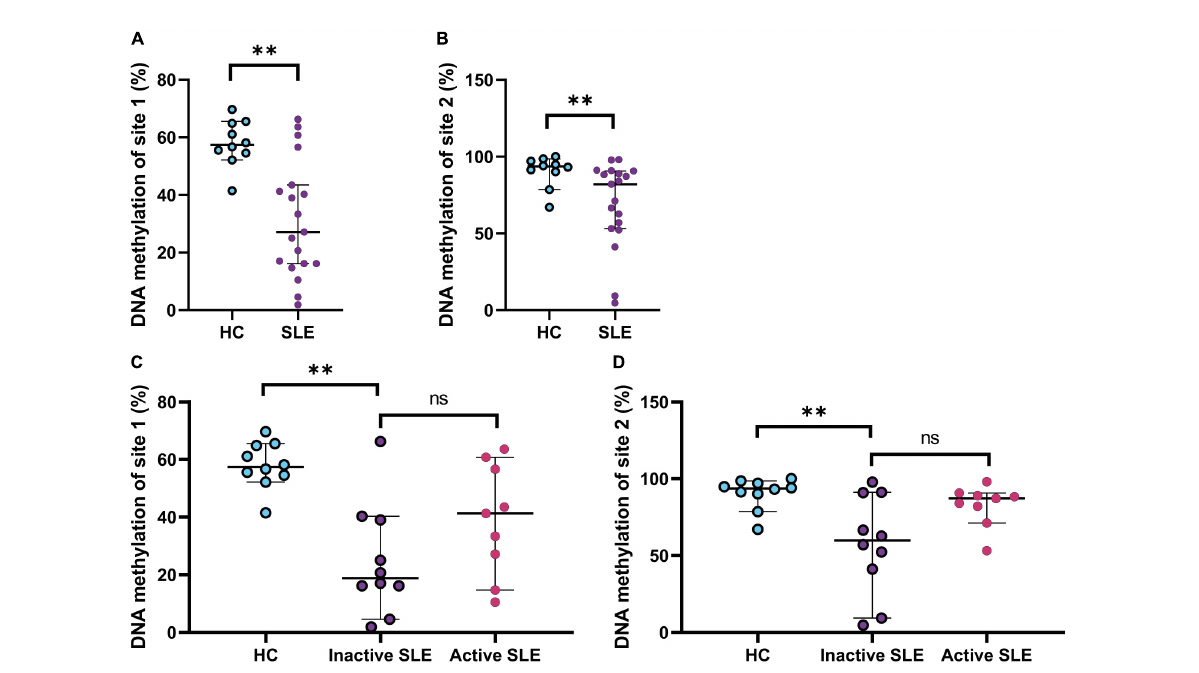
FIGURE4 DNA methylation status of IFI44L gene on rNAV B cells. (A) Percentage of DNA methylation of site 1 on the promoter of the gene IFI44L in HC and SLE patients. Mann–Whitney T -test was used to analyze and median and 95% CI are depicted in the figures. (B) Percentage of DNA methylation of site 2 on the promoter of the gene IFI44L in HC and SLE patients. Mann–Whitney T -test was used to analyze and median and 95% CI are depicted in the figures. (C) Percentage of DNA methylation of site 1 on the promoter of the gene IFI44L on HC, inactive and active SLE patients. Kruskal Wallis with multiple comparisons used to analyze and median and 95% CI are depicted in the figures. (D) Percentage of DNA methylation of site 2 on the promoter of the gene IFI44L on HC, inactive and active SLE patients. Kruskal Wallis with multiple comparisons used to analyze and median and 95% CI are depicted in the figures. * P ≤ 0.05; ** P ≤ 0.01; *** P ≤